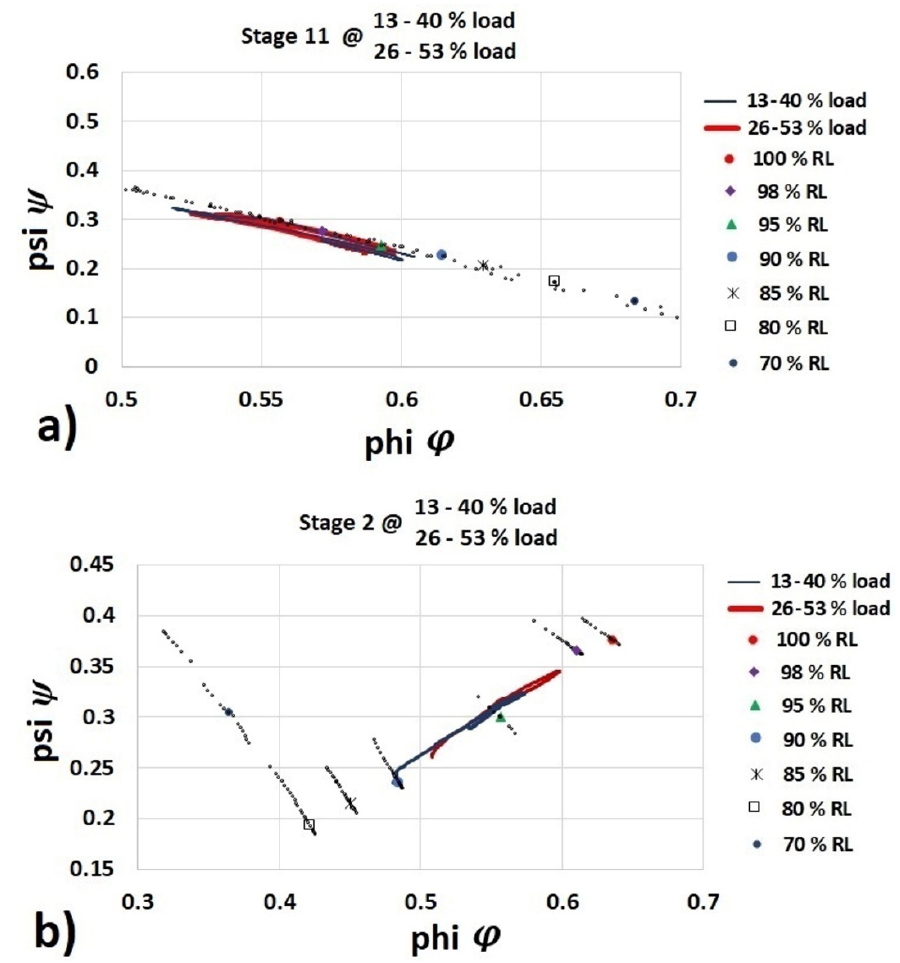
Figure 20. Transient compressor response on the stage characteristic map @ 13–40% load and 26–53% load with bleed air, ( a ) stage 11, ( b ) stage 2.